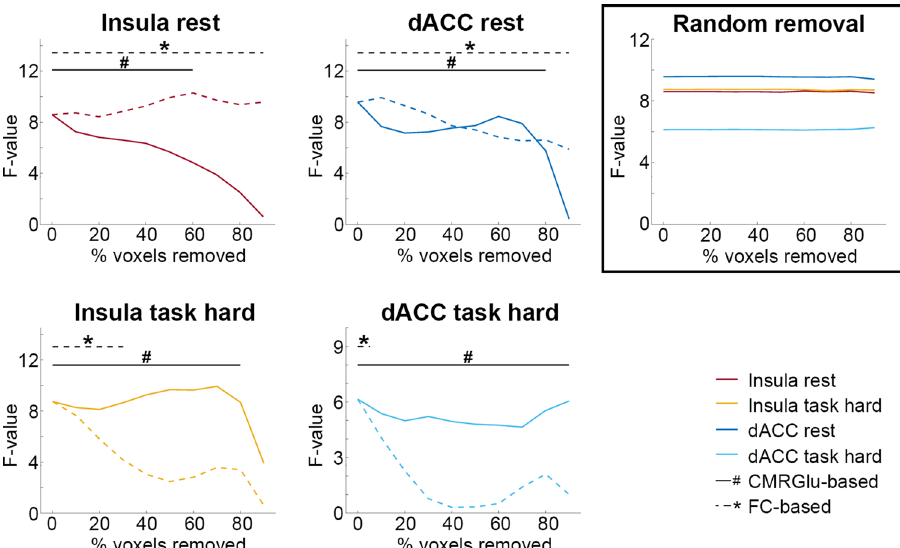
Fig. 5 Simulated perturbations of learning-induced changes in MCM. We aimed to identify whether learning-speci fi c MCM effects in Fig. 3 were driven by glucose metabolism (CMRGlu) or functional connectivity (FC). Voxels of the occipital cortex (i.e., the MCM target region) were progressively removed based on increasing values of CMRGlu (solid lines) or FC (dashed lines) and training effects were recalculated (F-value of group*time interaction). At resting-state simulated removal of voxels based on CMRGlu abolished training-induced MCM effects for both connections towards the occipital cortex, which was, however, not the case for FC (top row). The inverse pattern was observed for the hard task condition, where training-speci fi c decreases in MCM were nulli fi ed when removing voxels based on FC, but not CMRGlu (bottom row). # /solid black lines: p < 0.05 when removing voxels based on CMRGlu. */dashed black lines: p < 0.05 when removing voxels based on FC values. 0% of voxels removed represents the results shown in Fig. 3 (i.e., when using the entire target region). Of note, randomly removing up to 90% of voxels in the occipital cortex did not affect the learning-induced changes in MCM at all (right top panel, all p < 0.05), highlighting the speci fi city of CMRGlu and FC to drive MCM changes and indicating that effects are not dependent on the size of the target region. The colors for the random removal match those of the other panels. Data for the plots are provided in supplementary data 11 –